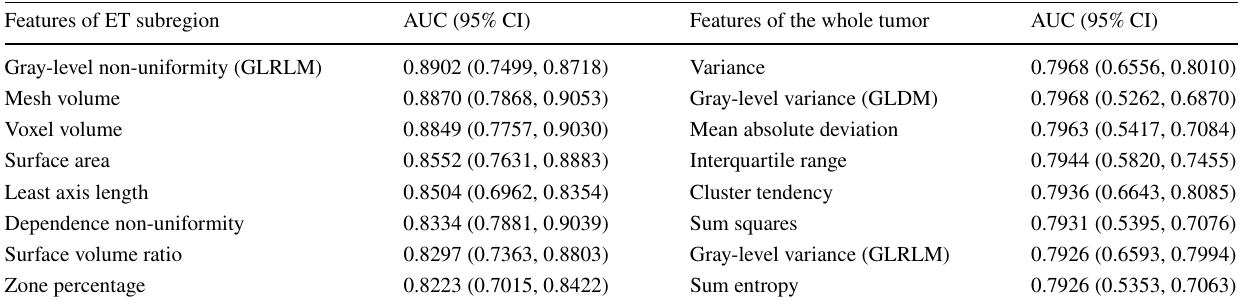
Table 1 Comparative results of AUC of the eight top-ranked features from the T1-based ET subregion and the whole tumor for glioma